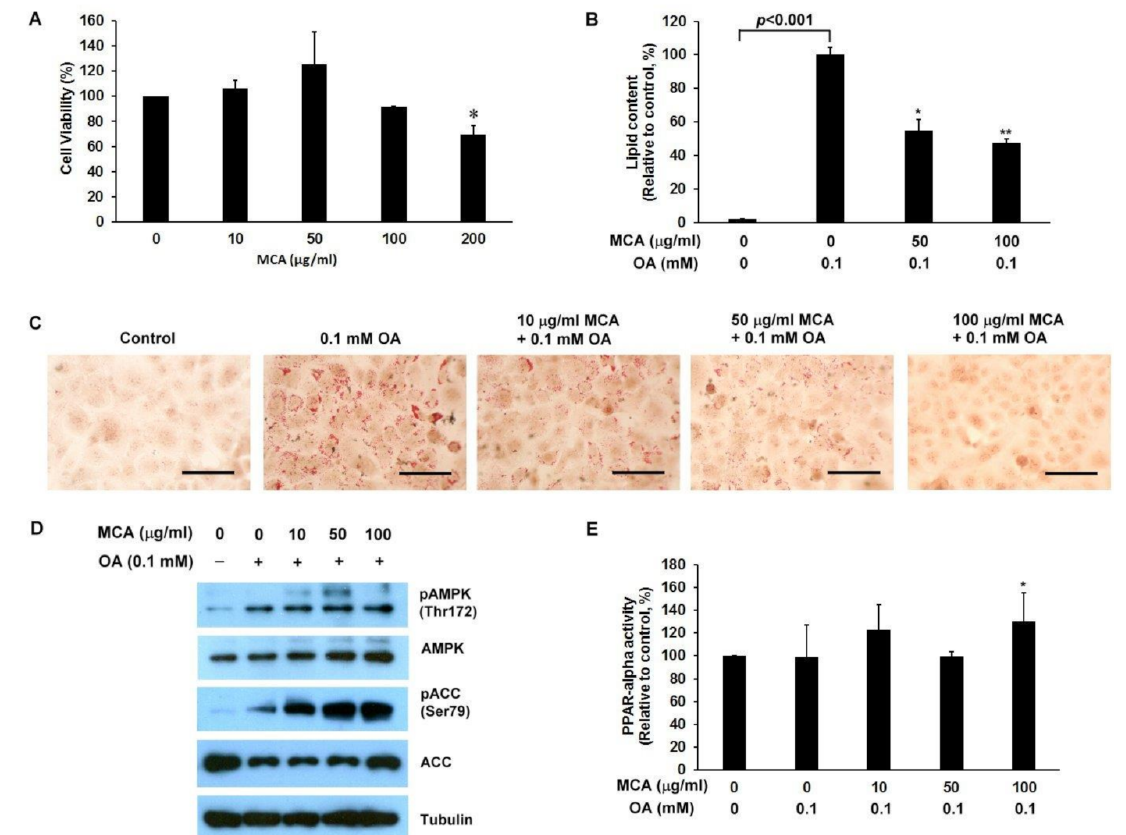
Figure 5. The effect of MCA on oleic acid-induced cellular lipid accumulation in HuS-E/2 cells. ( A ) Cell viability following treatment with MCA for 24 h in HuS-E/2 cells. ( B ) Quantitative analysis of lipid deposition in the Oil Red O-stained HuS- E/2 cells. ( C ) Micrographs of the Oil Red O staining using a microscope at 200 × original magnification. Control represents cells without oleic acid (OA) or MCA treatment. ( D ) Western blot analysis for pAMPK and pACC, total AMP-activated protein kinase (AMPK) and ACC. Tubulin served as a loading control. ( E ) The levels of peroxisome proliferator-activated receptor-alpha (PPAR-alpha) activity were examined by enzyme-linked immunosorbent assay (ELISA). The scale bar is 100 µ m. Experiments were performed in triplicate and data are presented as mean ± SEM of three independent experiments. Control vs. MCA, * p < 0.05; ** p < 0.01; *** p <